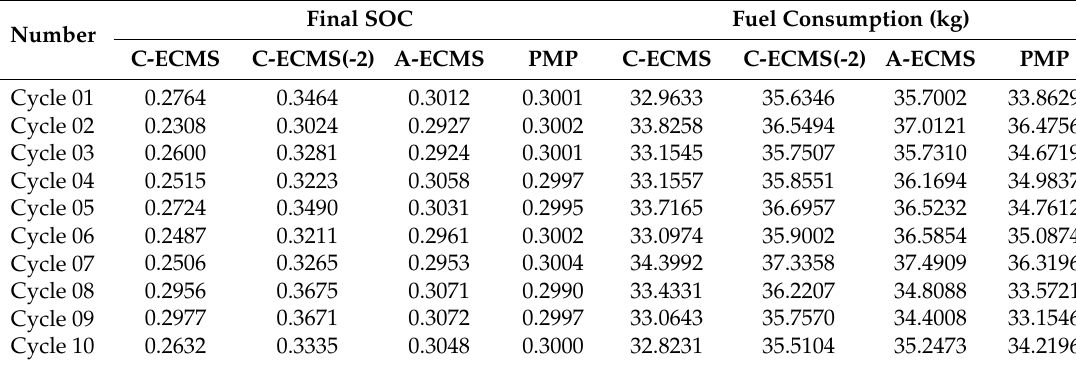
Table 10. Comparison statistics with initial SOC =